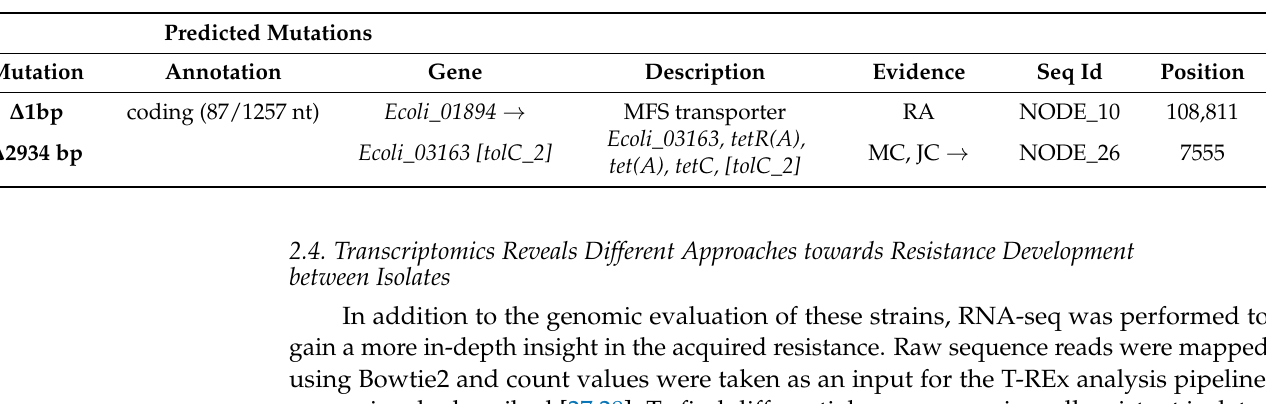
Table 3. Genomic mutations specific for the TCATa R isolate. Deletions are denoted by the delta sign ( ∆ ). Evidence from mapped reads is categorized in read alignment (RA), missing coverage (MC) and/or new junction